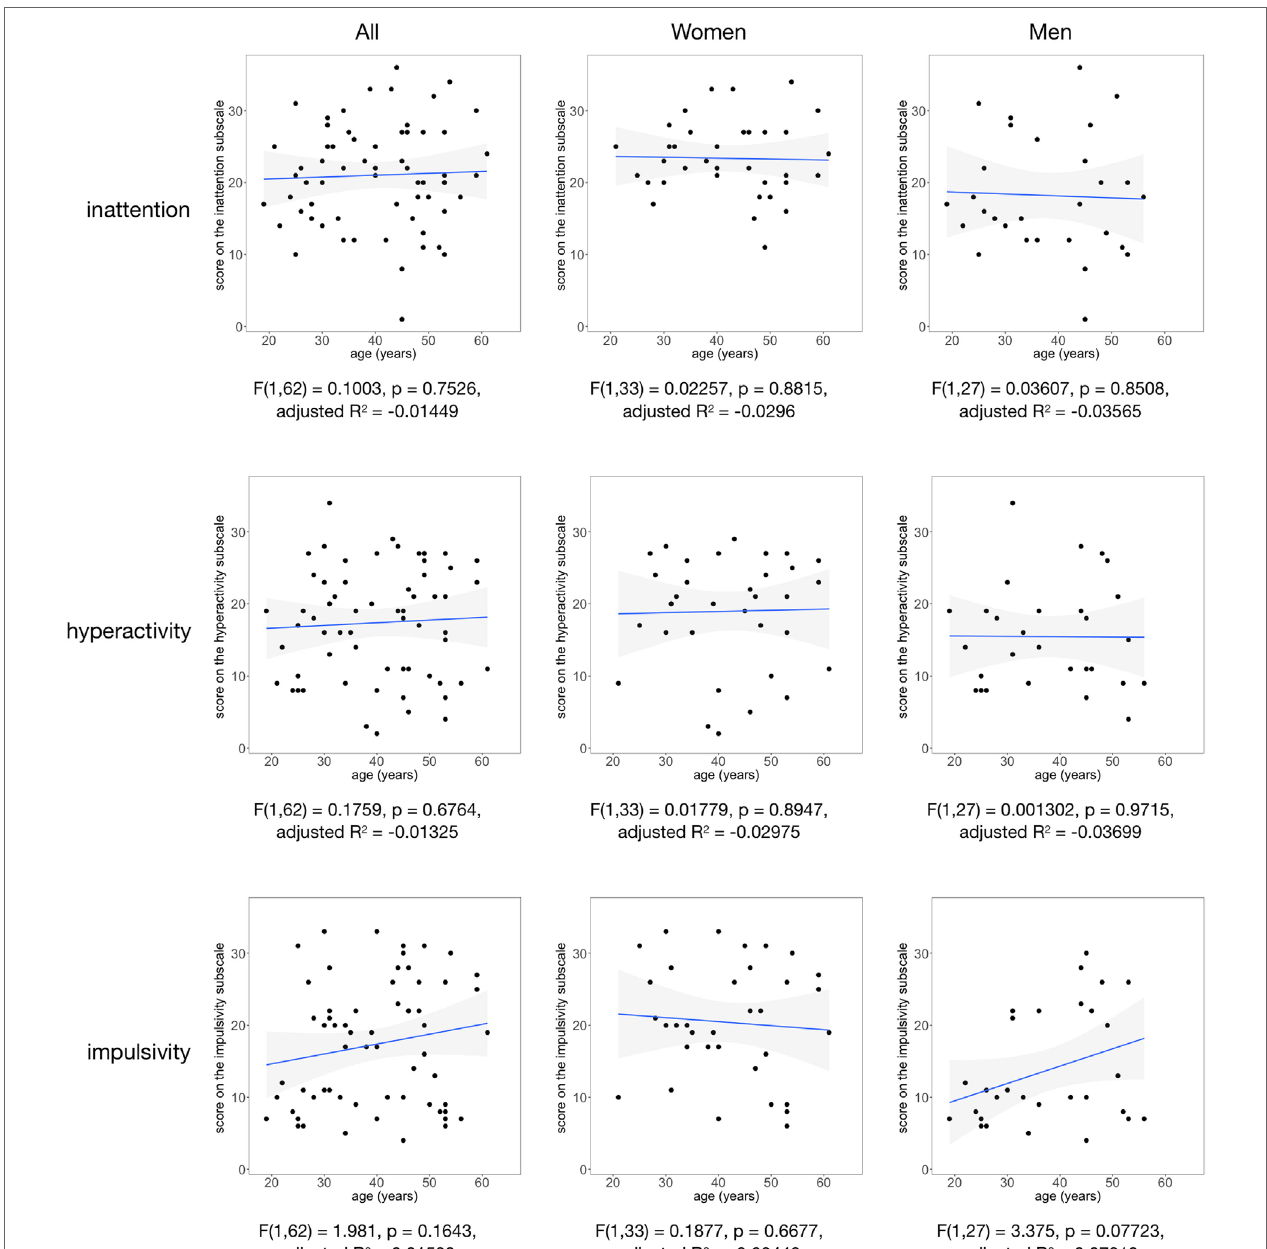
FigUre 2 | The scores on the Conners Adult ADHD Rating Scales inattention, hyperactivity, and impulsivity subscales are shown as a function of age for all participants (left column), women (middle column), and men (right column). Regression line and 95% confidence intervals (gray shade) are